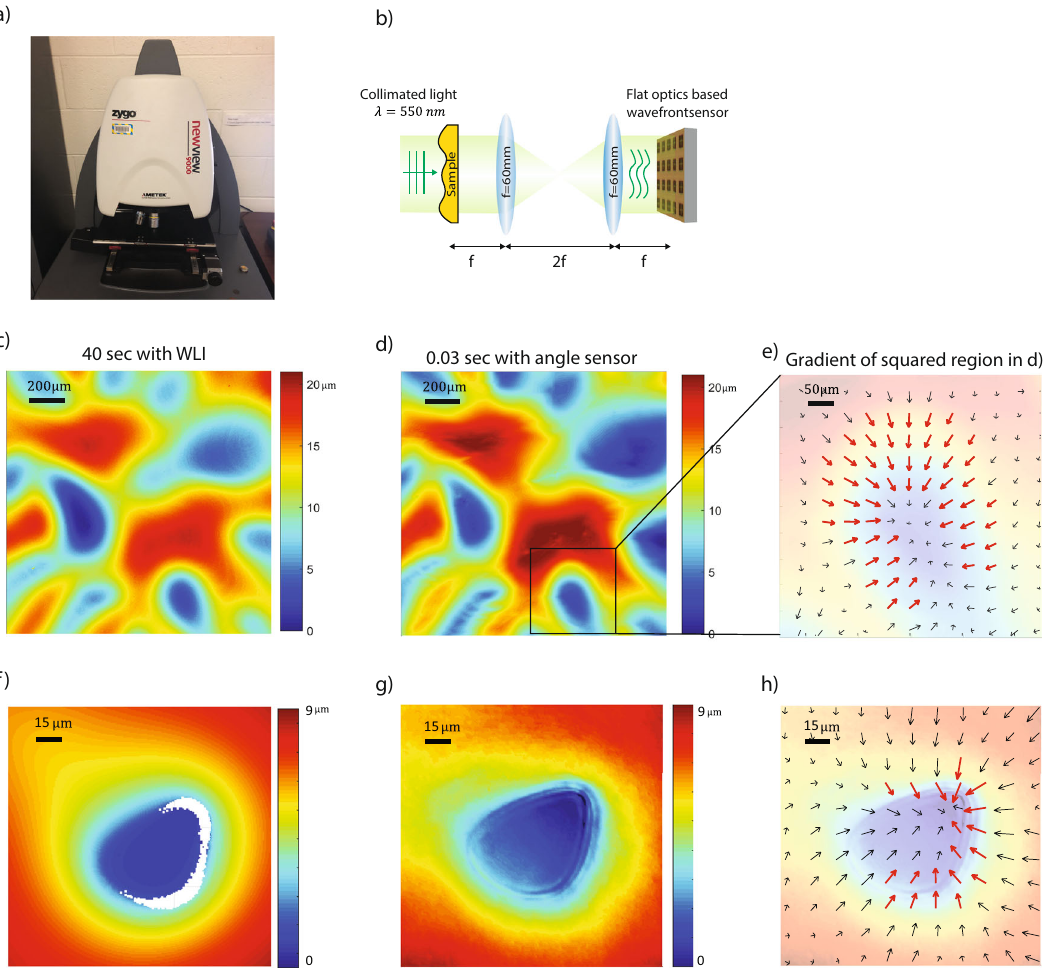
Fig. 4 Surface pro fi le measurement comparison with white light interferometer. a Photo of a commercial white light interferometer (Zygo NewView 9000) for surface pro fi le measurement. b Optical setup for surface pro fi le measurement using the proposed wavefront sensor where f is the focal length of the lens. c Surface pro fi le of a PMMA polymer on a microscope slide measured with a WLI. d Same sample as in c measured with the proposed wavefront sensor. e Close-up view of the cropped region in d where the slope of the surface is represented with arrows indicating projected vector components. f PMMA polymer surface measured with a WLI equipped with a 10× objective lens. g Same sample as in f measured with our wavefront sensor equipped a 10× objective lens. h Red arrows indicate the region with steep slope where WLI fails to report the